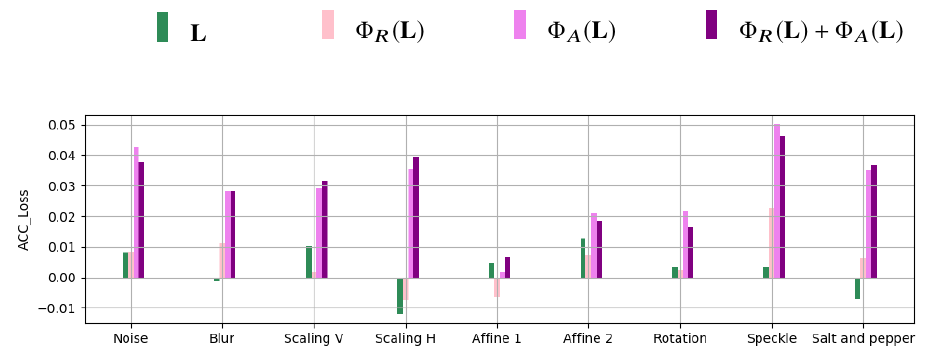
Figure 12. Values of ACC P for different processing operations and feature